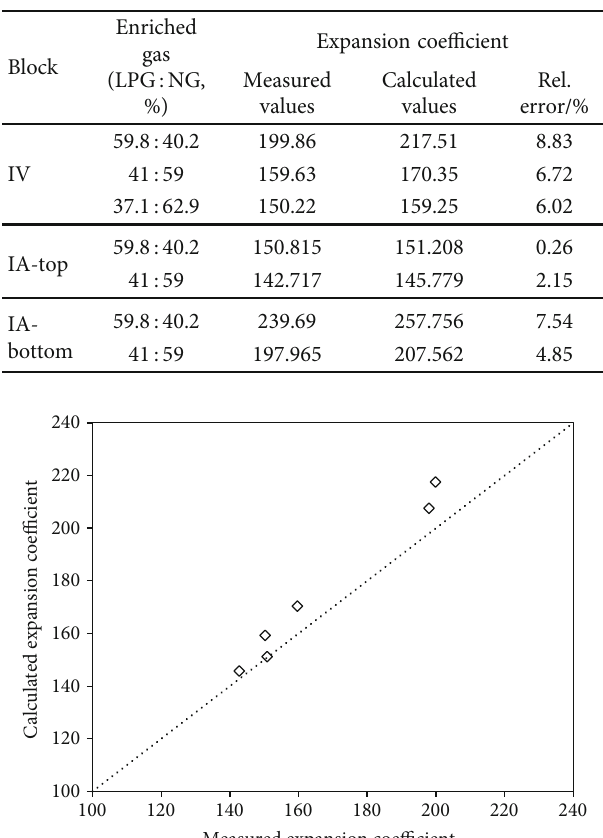
Table 2: Comparison of expansion coe ffi cients.